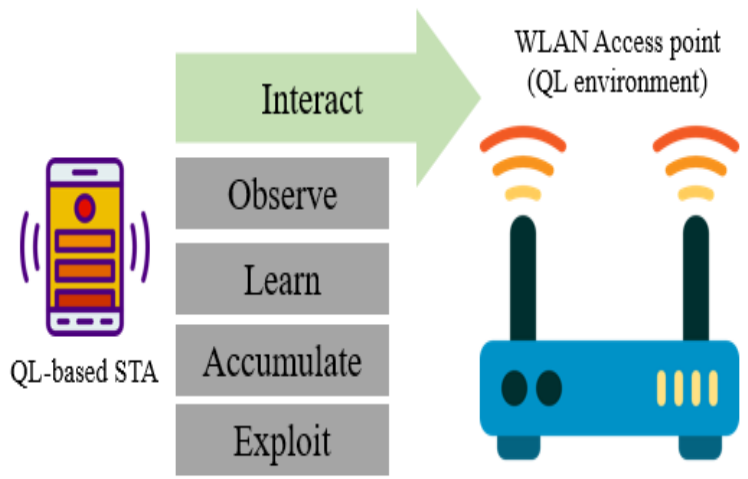
Figure 1. A QL-based WLAN station (STA) interacting with its QL environment for